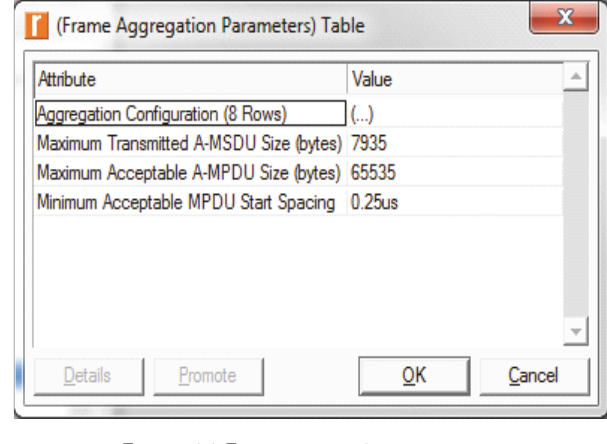
Figure 36: Frame aggregation parameters.